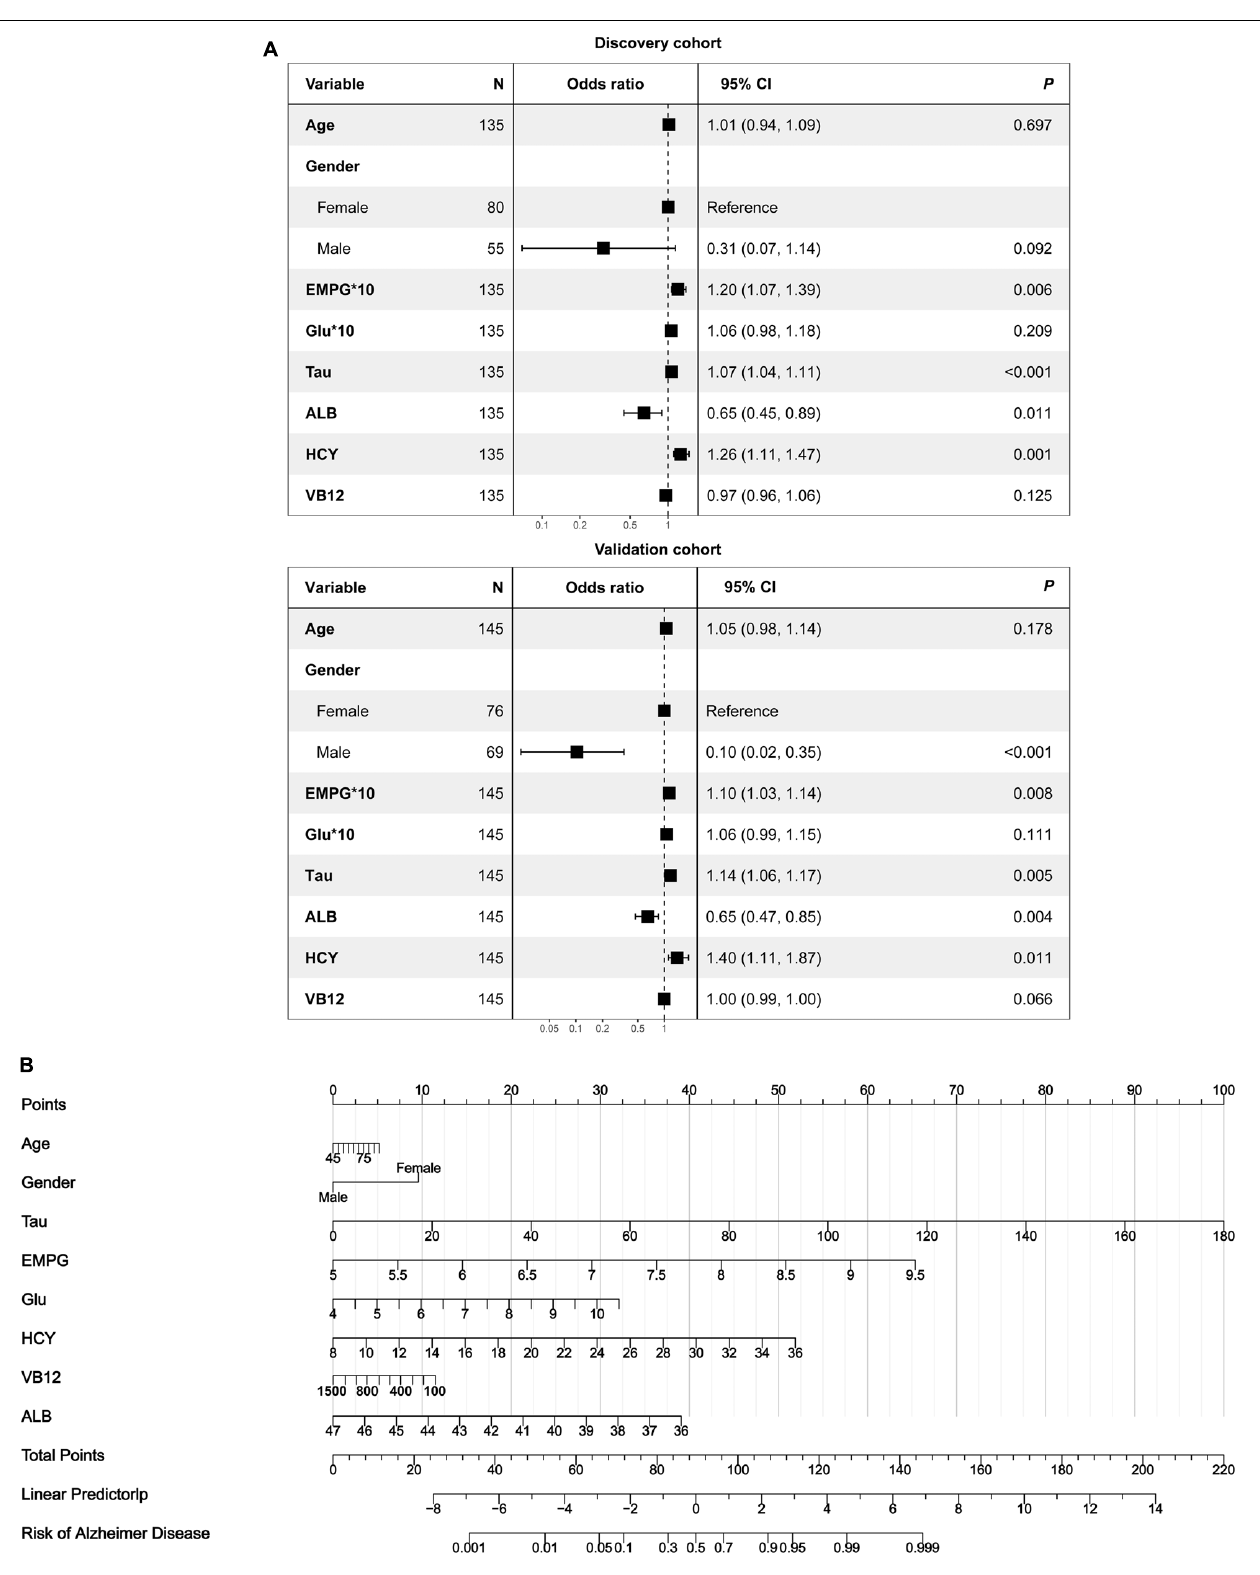
FIGURE 5 | Development of a multipredictor nomogram for AD diagnosis. (A) The forest plot of OR of selected features in discovery and validation cohorts. (B) Predictive nomogram integrates multiple selected features.